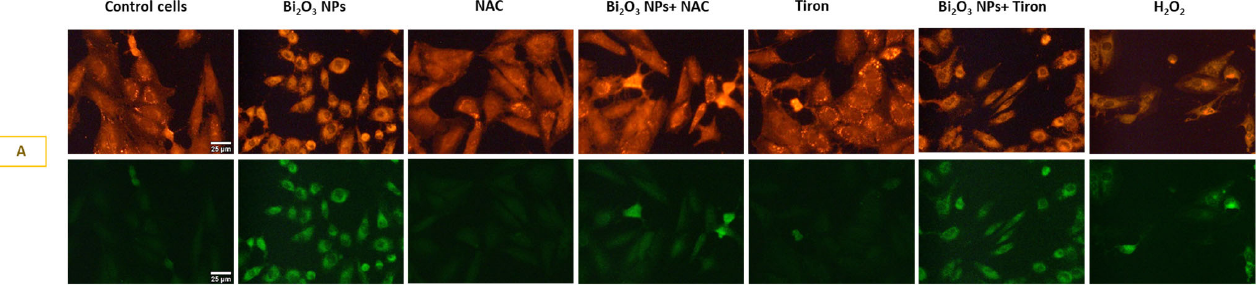
Figure 3. Lipid peroxidation (LPO) was detected using live-cell imaging dye ( A ) that preferentially localizes in a hydrophobic environment and fl uoresces green in proportion to LPO. BODIPY green fl uorescence was calculated in ImageJ software ( B ). LPO was also assessed by a more conventional method by quantifying TBARS spectrophotometrically ( C ). Data represented are mean ± SD of three identical experiments ( n = 3) conducted in triplicates. * Statistically signi fi cant di ff erence compared to the controls ( p < 0.05). Any signi fi cant ( p < 0.05) di ff erence in response from that mediated by NPs and the addition of either NAC or Tiron is denoted by α and β , respectively. 3.4. BNPs Signi fi cantly Induced NO Level That Was Least Preventable by Antioxidants in HUVE Cells BNPs induced signi fi cant NO production in HUVE cells (Figure 4A infra-red images in lower panel), and it was comparatively li tt le a ff ected by the two antioxidants, when compared to other biomarkers evaluated in this study. NAC and Tiron almost equally inhibited NO production due to NPs. The inhibitory e ff ects of NAC and Tiron on NP- mediated NO production were 17 ± 3% and 15 ± 3% respectively. As can be seen in DAR- 1 fl uorescence quanti fi cation (Figure 4B), NO generation was inversely proportional to the live-cell dye calcein-AM (Figure 4A green images in upper panel, and 4 D calcein-AM- fl uorescence plo tt ing) suggesting NO generation due to BNPs as a cytotoxic event in HUVE cells. Recall that the higher the calcein-AM fl uorescence in cells, the lower the cy- totoxicity.